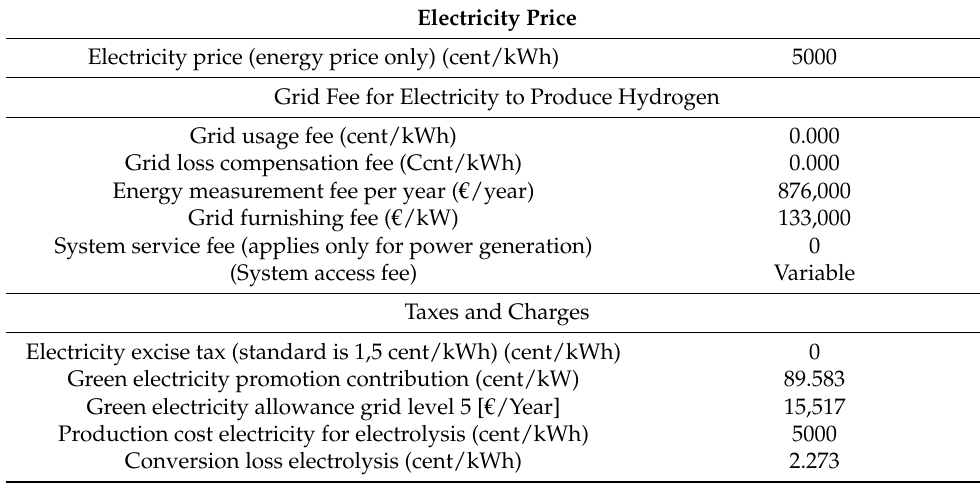
Table 9. Production cost of hydrogen.